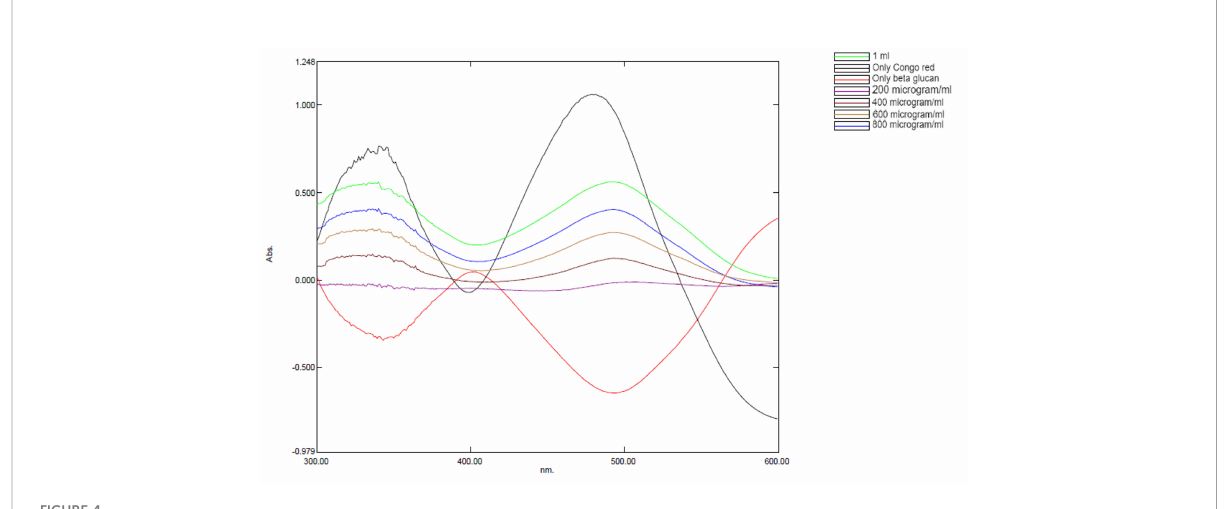
FIGURE 4 Bathochromic shift observed in yeast b -glucan and Congo red